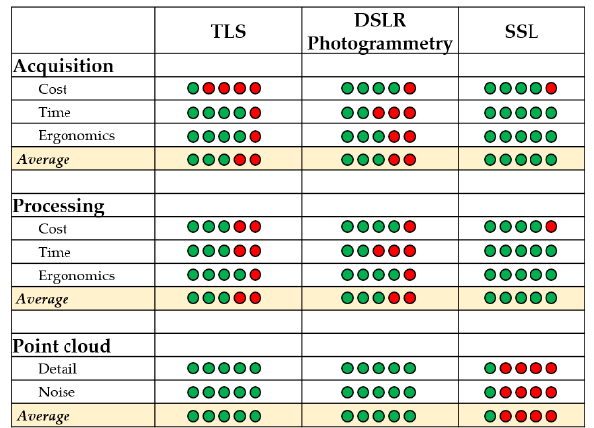
Figure 6. Simplified synthesis of quality